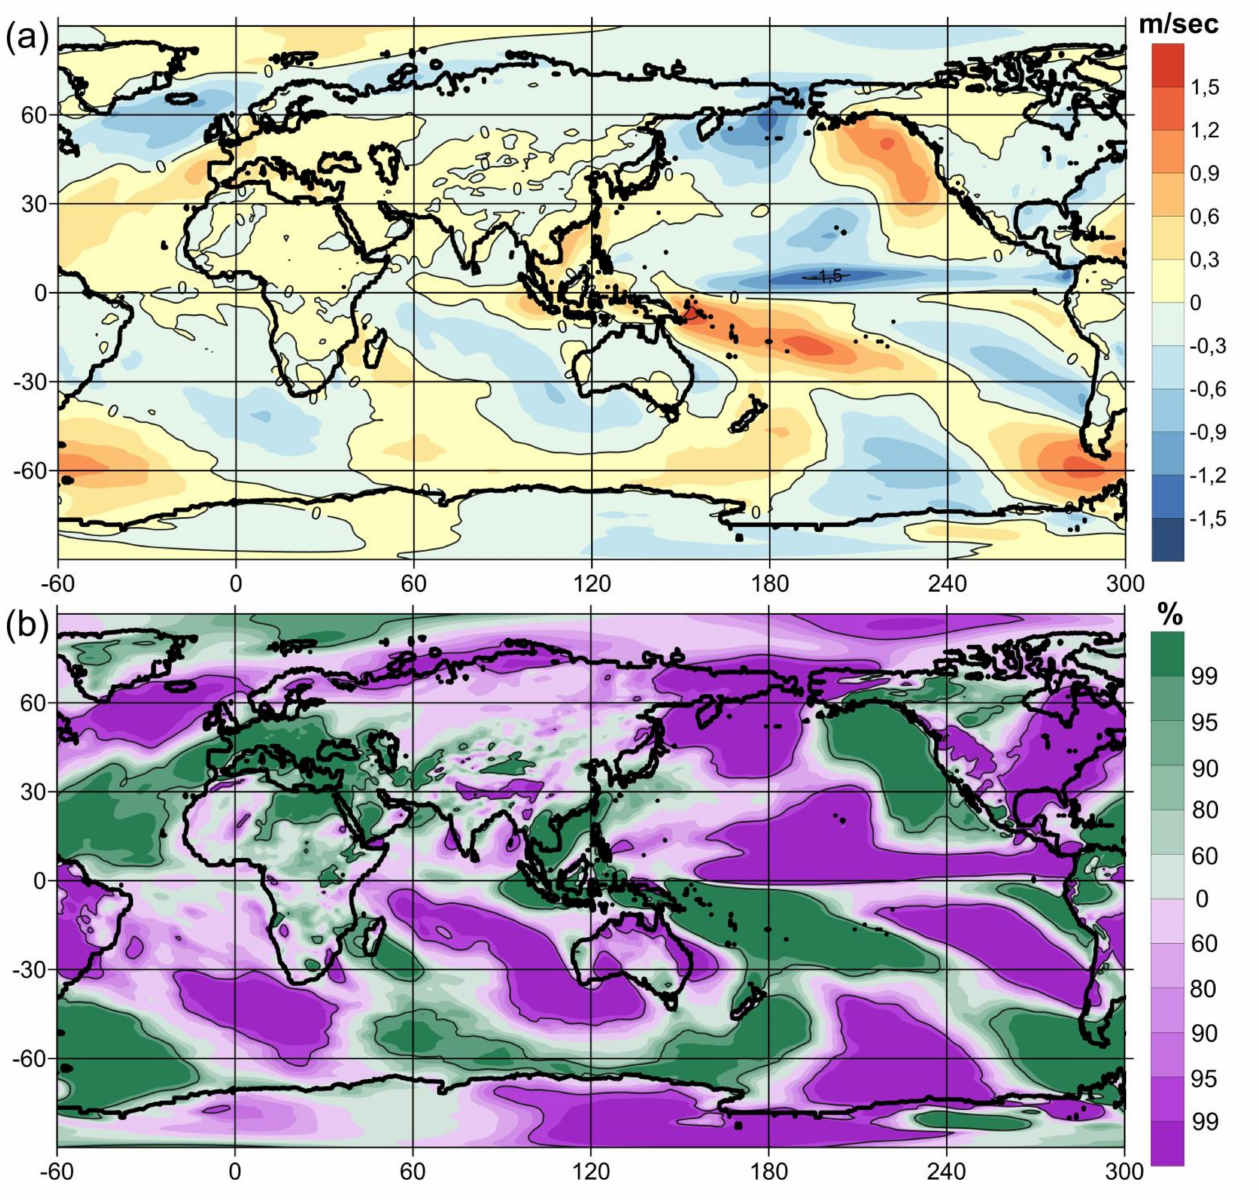
Figure 7. The difference between the average anomalies of the meridional (direction from south to north) wind speed component at a height of 10 m from the surface between the opposite phases of the Global Atmospheric Oscillation by GAO2 index ( a ). The probability values for ( a ) according to Student’s t -test ( b ). TAP anomalies correlate well with total cloud cover (TCC) anomalies (Figure 9). Positive TCC anomalies are located in the tropics of the central part of the Pacific Ocean, in the region where the planetary convection region shifts during El Niño.